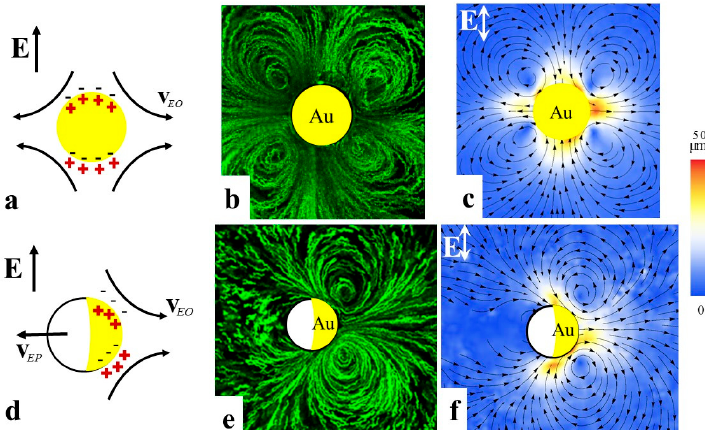
Figure 1. Induced-charge electro-osmosis (ICEO) around an immobilized gold sphere ( a – c ) and a Janus glass-gold sphere ( d – f ) as established by Peng et al. [14]. ( a , d ) Scheme of charge separation in presence of the electric field; ( b , e ) Experimental flow patterns driven by an AC field and visualized by fluorescent tracers; ( c , f ) Velocity fields; note quadrupolar symmetry of flows around the metal sphere in ( b , c ) and broken left-right symmetry of flows around the immobilized Janus sphere which acts as a pump; the flows are stronger on the Au (right) side than on the glass (left) side of the sphere in ( e , f ) [14]. Adapted with permission from [14].